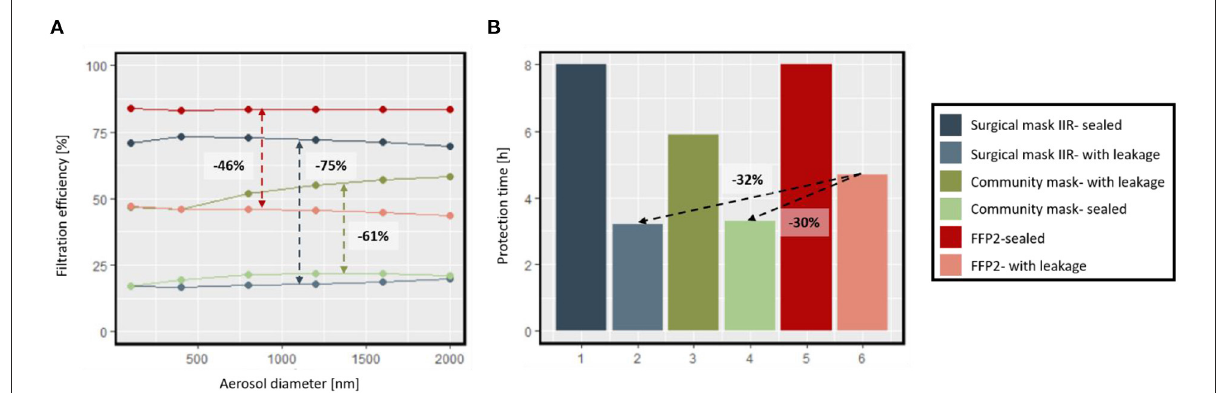
FIGURE9 (A) Filtration efficiency for the surgical mask IIR, FFP2, and community mask by considering leakage, (B) protection time while the healthy and infected people both wear the same mask in an office room with